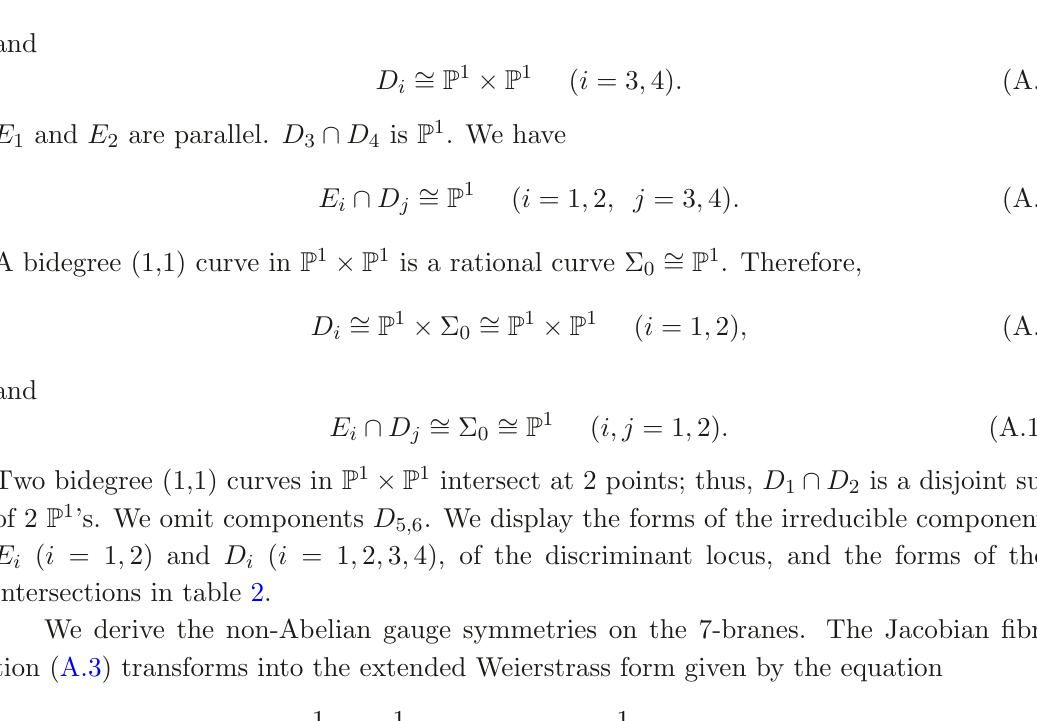
Table 2 . Discriminant components of a complete intersection (A.1) of two (2,1,1,1) hypersurfaces in P 3 × P 1 × P 1 × P 1 , and their intersections. Components D 5 and D 6 are